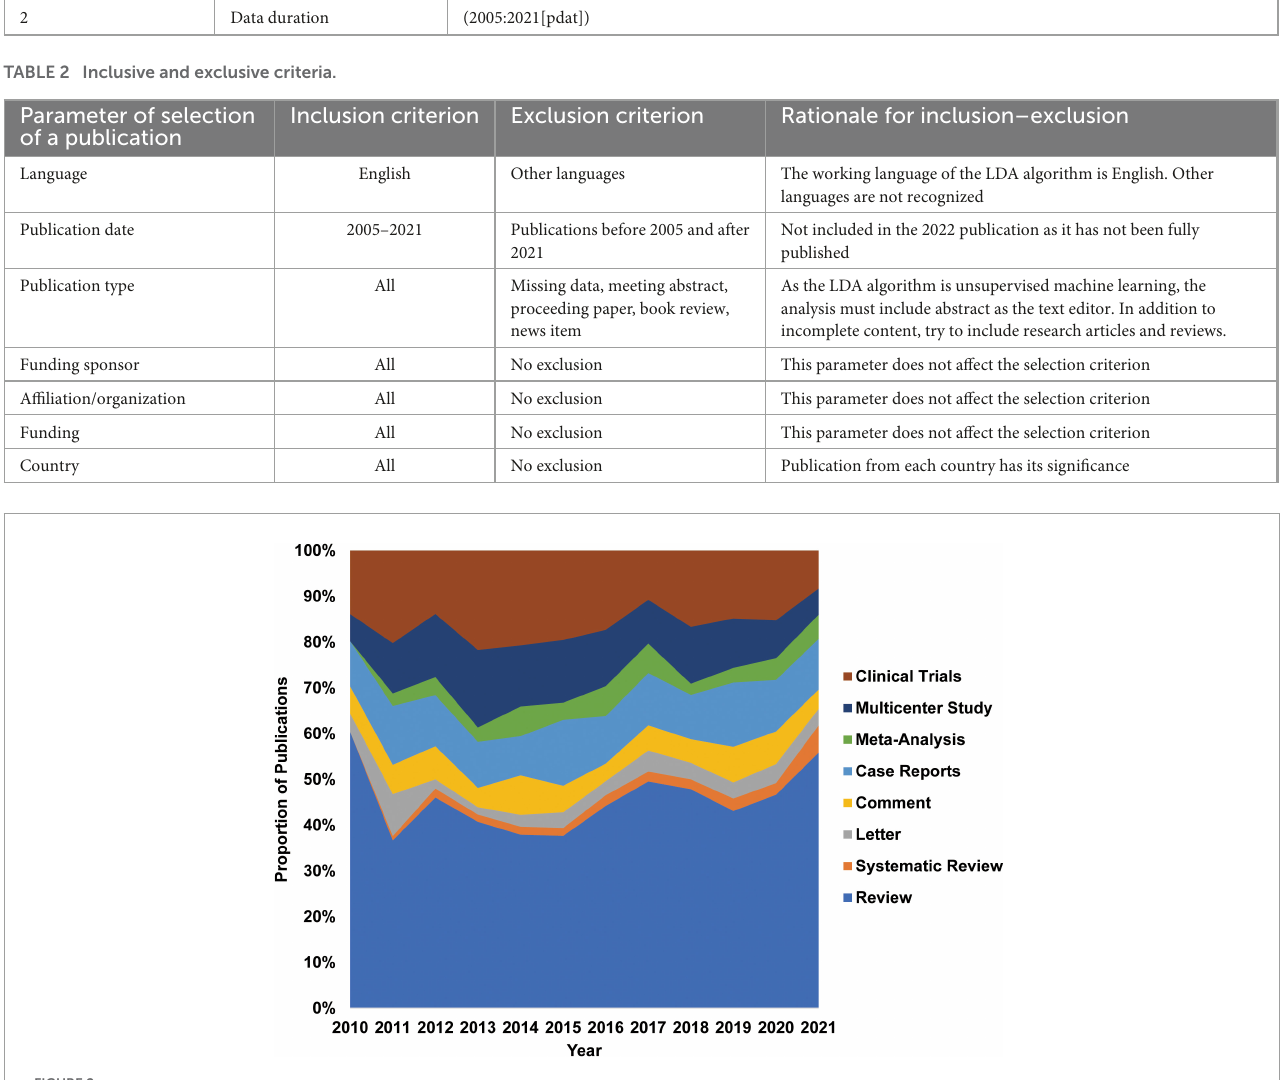
FIGURE2 Clinical trials and multicenter studies have a large proportion of research. We divide publications into eight categories according to the types provided in the database. Data were shown by